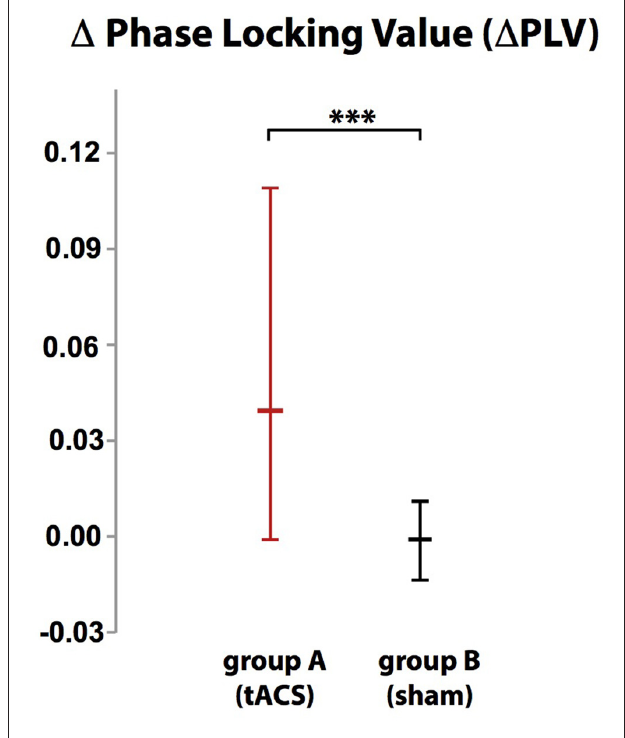
FIGURE 3 | While there was no difference in phase-locking value ( ∆ PLV) between blocks in group B (sham stimulation), ∆ PLV increased in group A (tACS) documenting tACS-dependent manipulation of frontal midline theta (FMT) phase . Error bars indicate 95% confidence intervals. ∗∗∗ p < 0.001.